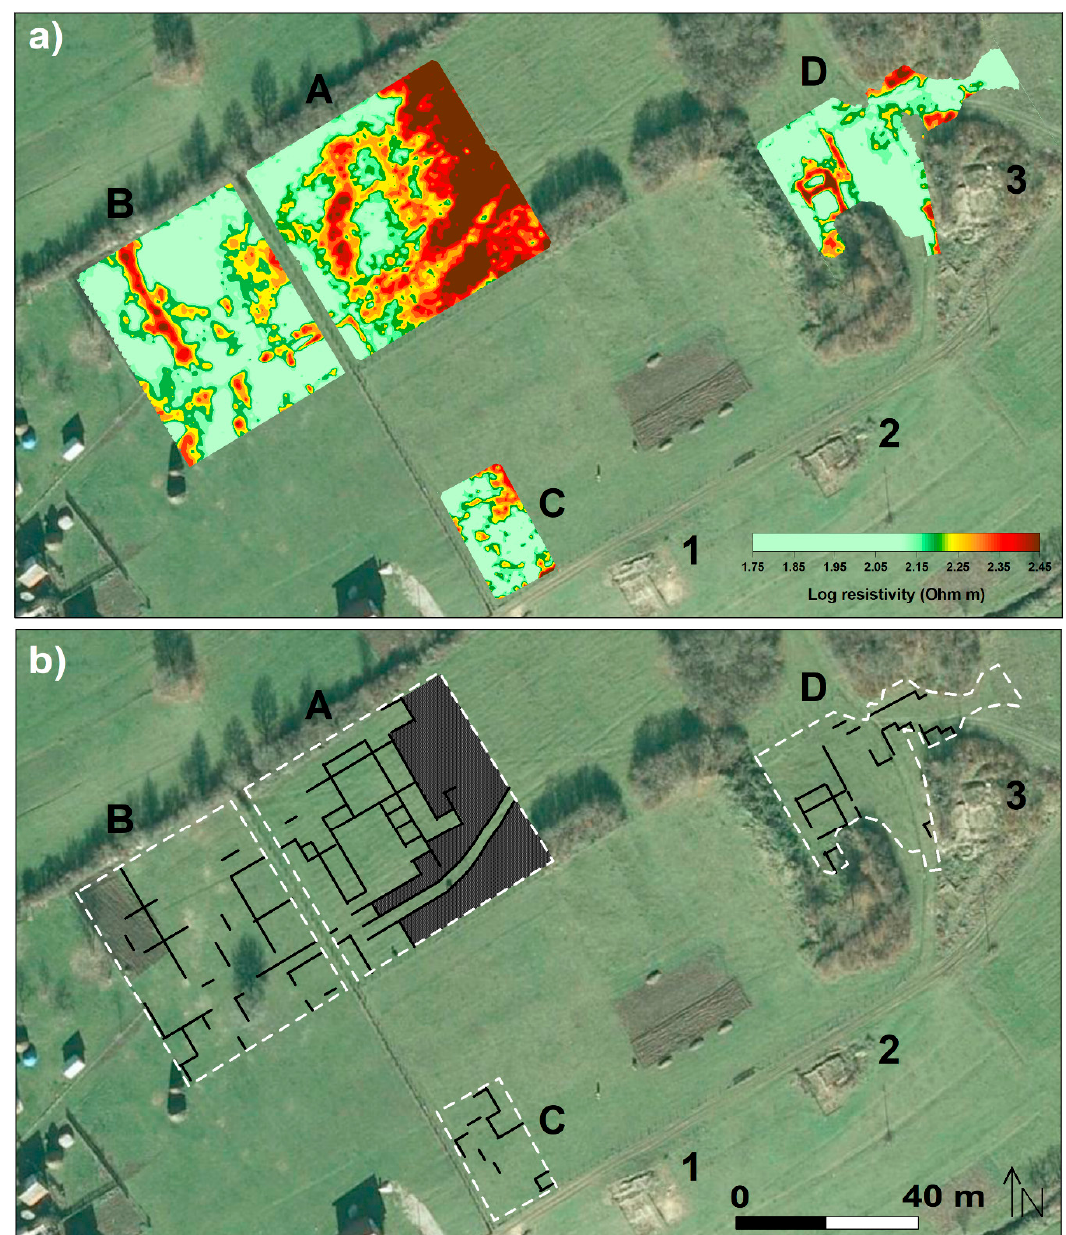
Figure 14. Municipium S: Electrical resistivity map relative to 1 m in depth on a Google Earth TM satellite image ( a ) and interpretation of geophysical anomalies ( b ).